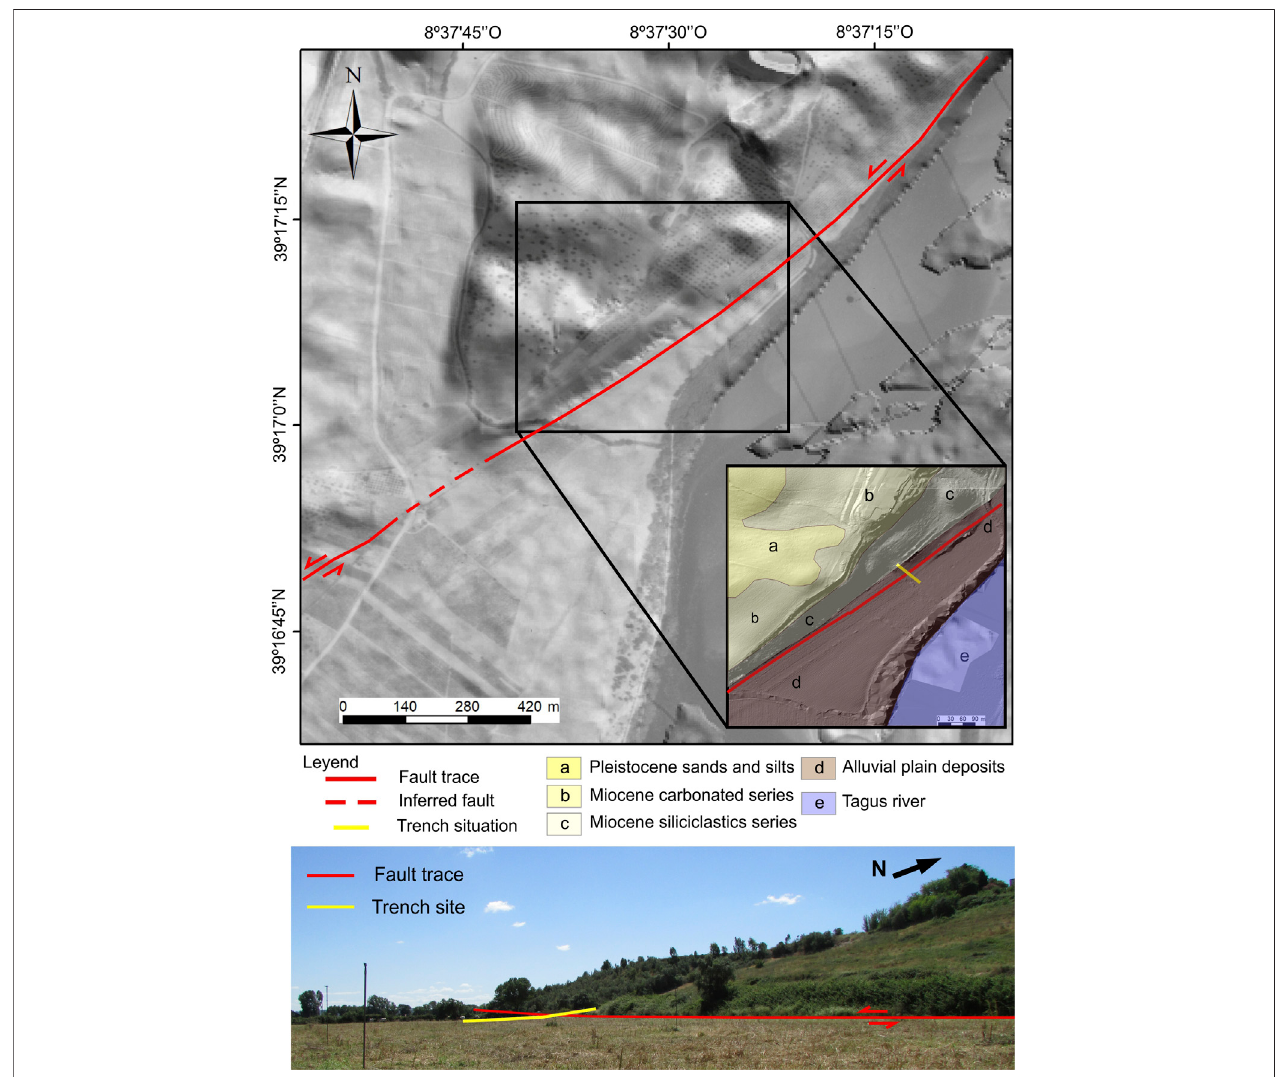
FIGURE 4 | Location of the Boavista trench-site: (A) aerial photograph superimposed on the 0.5 m-resolution DEM; (B) detail including the 1:50.000 geological map; (C) Photograph of the prominent fault scarp, facing NW.